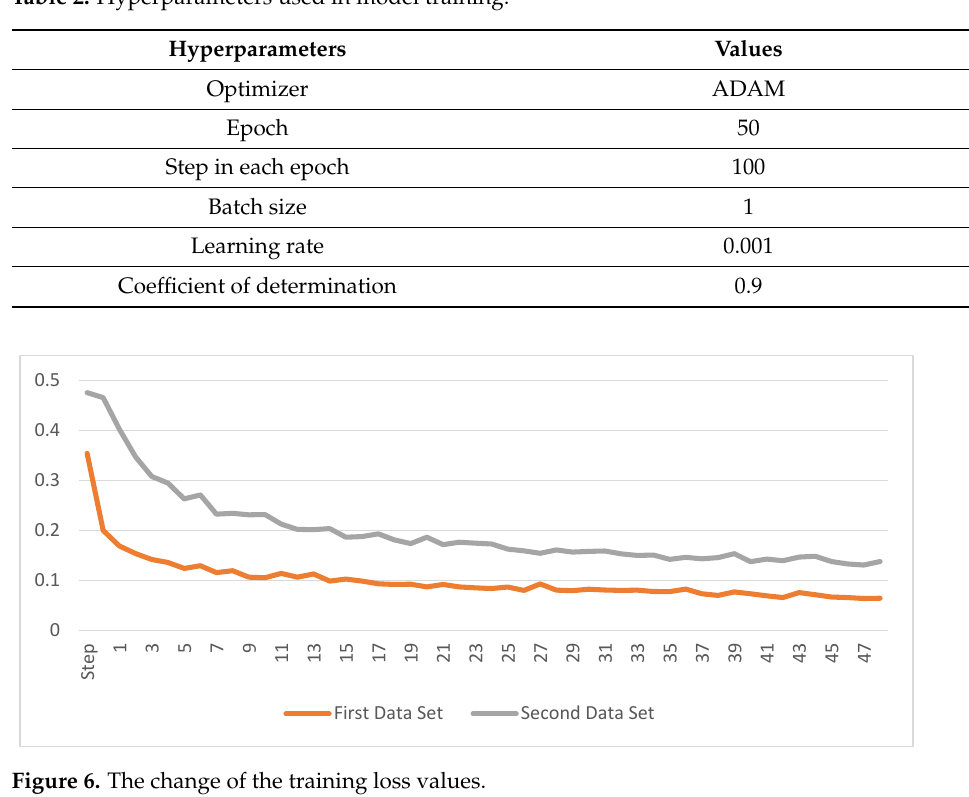
Figure 5. Image labeling processes with the VIA program (Images taken and during the first days ( a , b ) and last days ( c , d ) of incubation). Table 2. Hyperparameters used in model training.